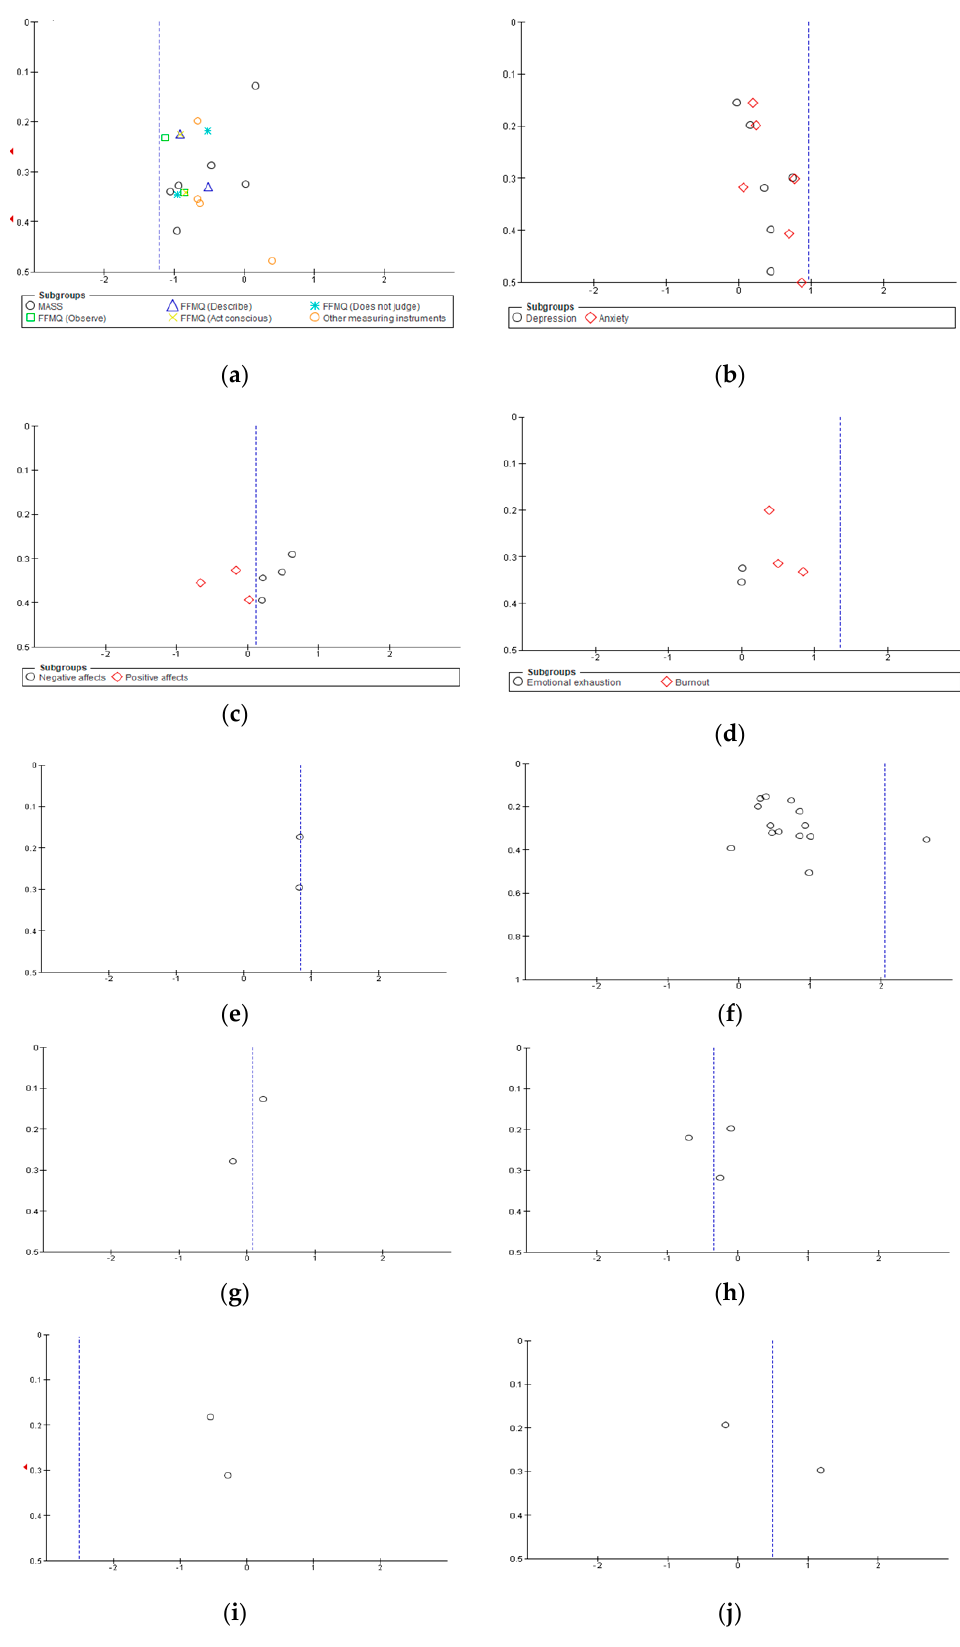
Figure 2. Risk of bias for all variables. ( a ) Mindfulness. ( b ) Depression and anxiety. ( c ) Negative and positive a ff ects. ( d ) Emotional exhaustion and burnout. ( e ) Fatigue. ( f ) Stress. ( g ) Engagement. ( h ) Resilience. ( i ) Wellbeing. ( j ) Quality of